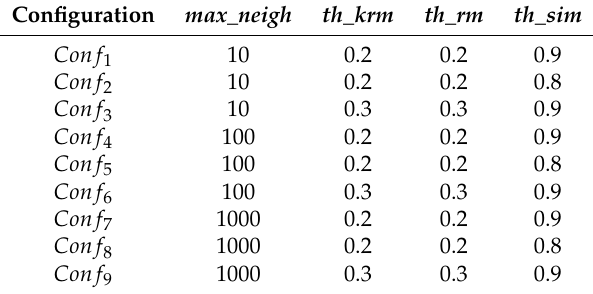
Table 3. Configurations of the Hammer query